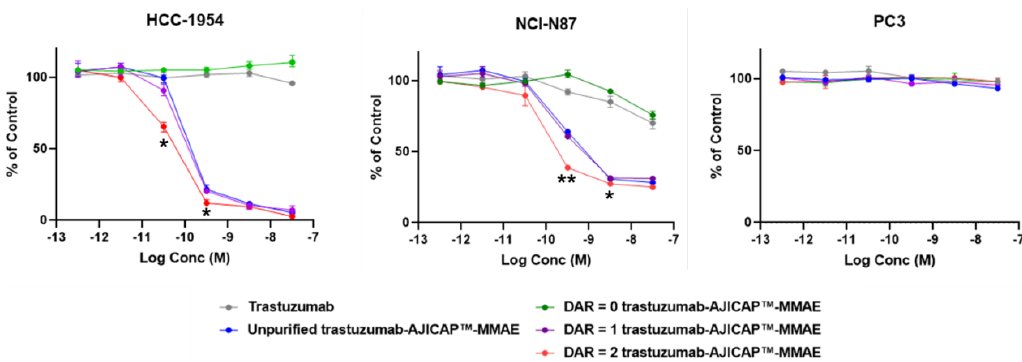
Figure 6. Summary of in vitro cytotoxic activity of purified DAR species: Data shown are mean ± SE from replicate samples (n = 3) for each treatment. Asterisks indicate significant differences compared of DAR = 2 ADC and DAR = 1 ADC at the same conc. point (* p < 0.05, ** p < 0.01, t -test).